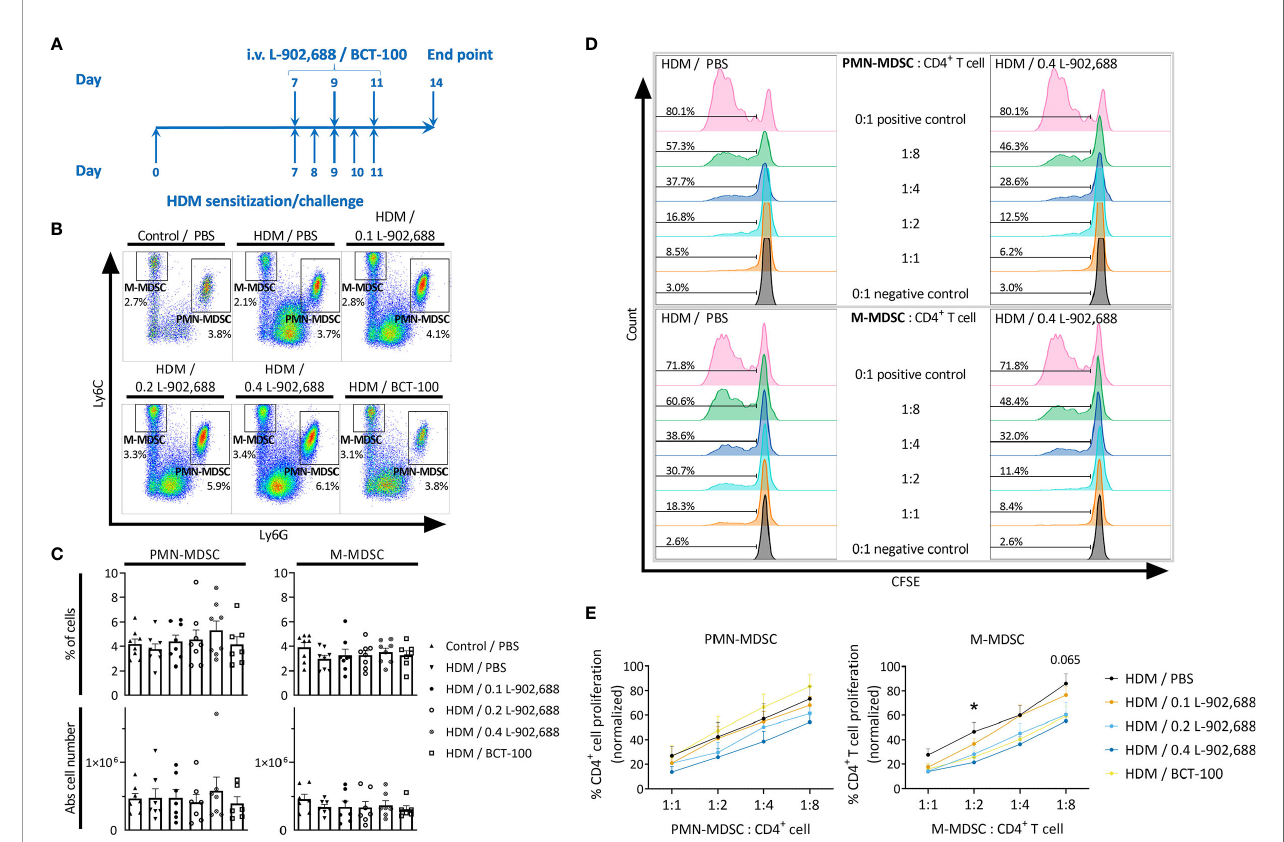
FIGURE 5 | The effect of EP4 agonist L-902,688 and arginase-1 therapy on the number and activity of innate MDSCs in the lungs in a murine model of asthma. 6- to 8- week-old female BALB/c mice were exposed to HDM or PBS on days 0, 7, 8, 9, 10 and 11. On day 7, 9 and 11 of the HDM model, mice were intravenously administered the EP4 agonist L-902,688 (0.1; 0.2 or 0.4 mg/kg), BCT-100 (20 mg/kg) or PBS. Three days after the last HDM exposure the lungs were collected. (A) Representative timeline of the HDM-induced murine model of asthma and EP4 agonist L-902,688/BCT-100 therapy. (B, C) The number of PMN- and M-MDSCs in the lungs were assessed by fl ow cytometry. (B) Representative fi gures of MDSC analysis. (C) Data presented as the percentage and the absolute number of MDSCs in total lung cells. Data was obtained from 7-8 independent experiments with 1-2 technical replicates. Results of individual experiments and mean ± SEM are shown. (D, E) PMN- and M-MDSCs were isolated from the lungs and cultured together with CFSE-labeled CD4 + T cells isolated from the spleens of naïve donor mice in the presence of anti-CD3/28 for 3 days. CFSE dilution was assessed by fl ow cytometry. (D) Representative fi gures of the CFSE dilutions of gated CD4 + CFSE + cells at different ratios of PMN- or M-MDSC: CD4 + T cells. (E) Analysis of the immunosuppressive activity of MDSCs in the lung. Data represent the normalised percentages of proliferating CD4 + T cells (positive control, without MDSCs, set to 100%). Data were pooled from 5-6 independent experiments. Results are presented as mean ± SEM. Statistical analysis was performed, comparing each MDSC: CD4 + T cell ratio, with one-way ANOVA followed by Tukey ’ s multiple comparisons test. * p < 0.05 and p = 0.065, comparing EP4 0.4 mg/kg with HDM